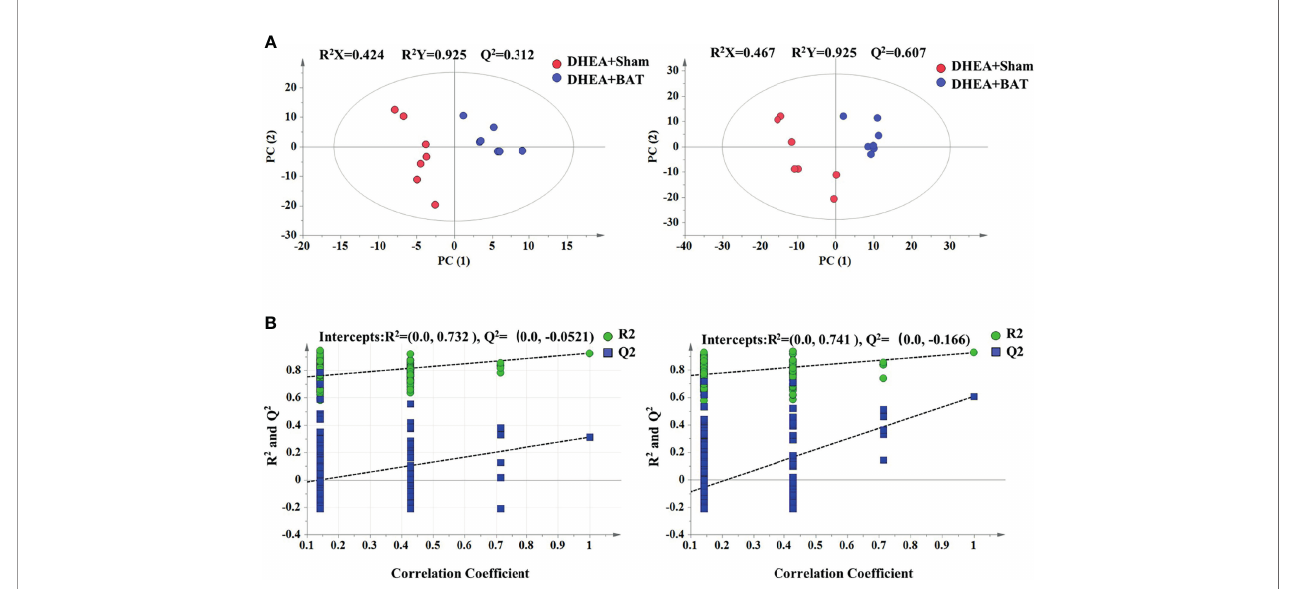
FIGURE 4 | Score plot of the PLS-DA model. (A) Score plot of the PLS-DA model in the positive and the negative mode. (B) Permutation test of the PLS-DA model in the positive and the negative mode. Green dots indicate R 2 and blue dots indicate Q 2 . PLS-DA , partial least squares discriminant